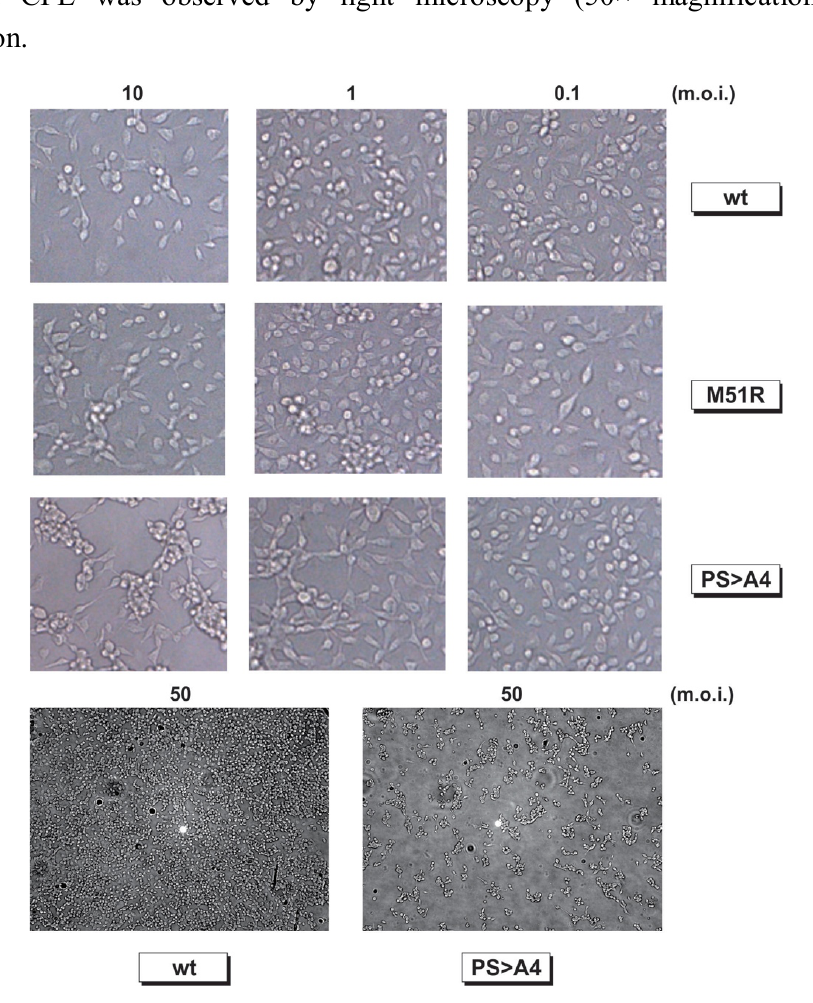
Figure 7. Microscopic analysis of virus-induced CPE in mosquito C6/36 cells. Mosquito C6/36 cells were infected with either VSV-WT, M51R, or PS > A4 at an MOI of 0.1, 1.0, or 10, and CPE was observed by light microscopy (200× magnification) at 24 h p.i. In a separate experiment, C6/36 cells were infected with either VSV-WT or PS > A4 at an